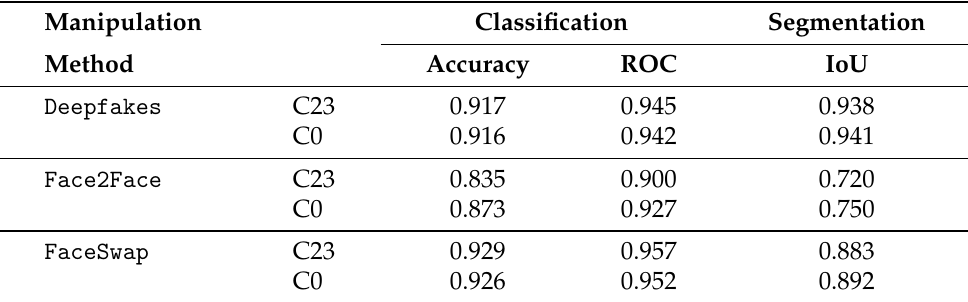
Figure 11. Randomly selected images from the result of detecting the real images by the model trained with the FaceSwap dataset. The left side of every pair of sub-images is the fake images and the right side of every pair of sub-images is the prediction result. Table 1. Results for detecting crop images altered by three manipulation